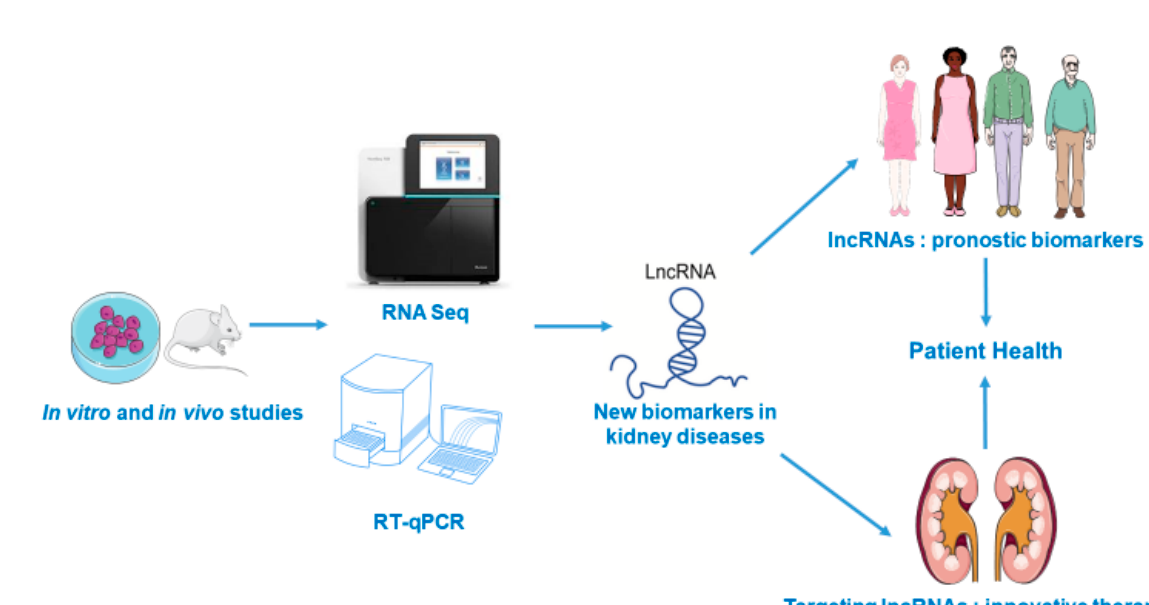
Figure 1. Use of lncRNAs as new prognostic biomarkers and novel therapeutic targets in renal diseases.